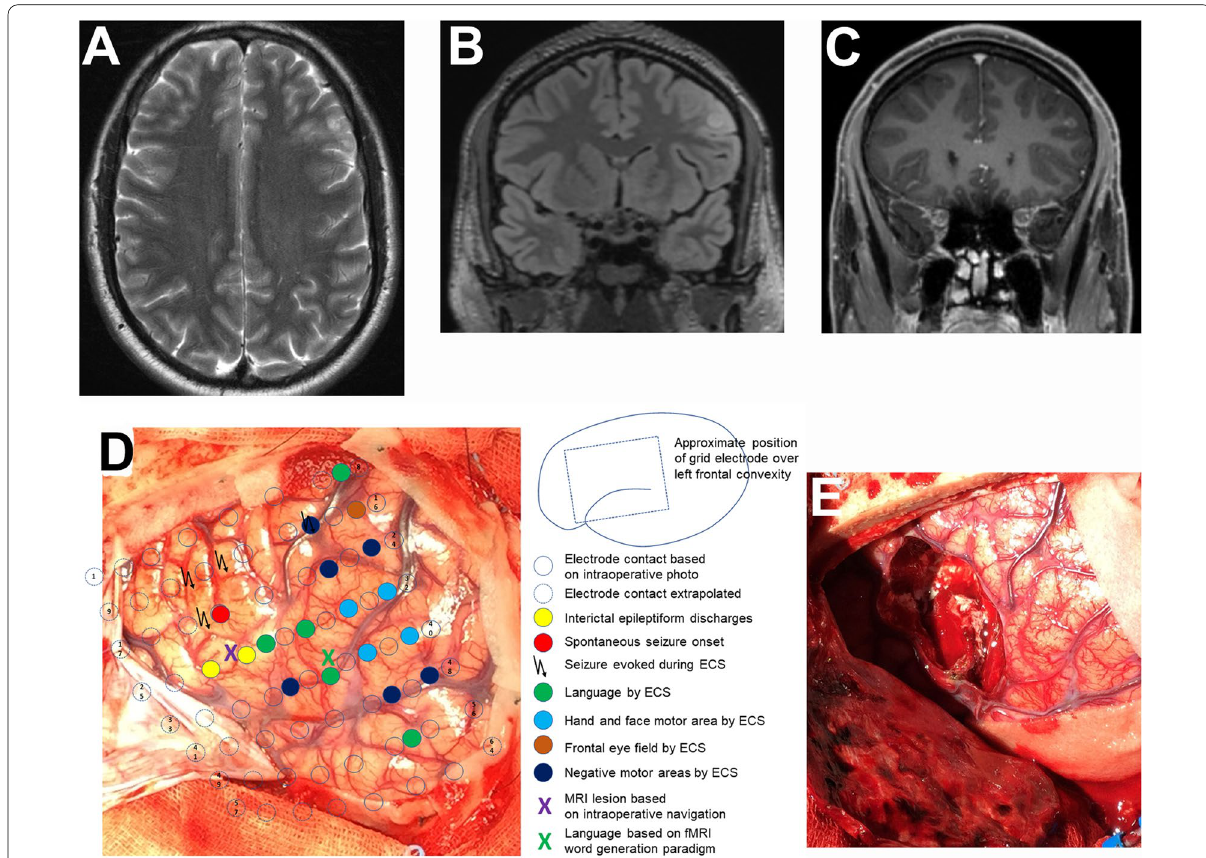
Fig. 2 Brain tumor in the left middle frontal gyrus with cortical and subcortical T2/FLAIR hyperintense signal ( A , B ) and partial Gadolinium enhancement ( C ) in a 24-year-old male patient. A Axial T2, B coronal FLAIR, C coronal T1 with Gadolinium, D intraoperative situs with